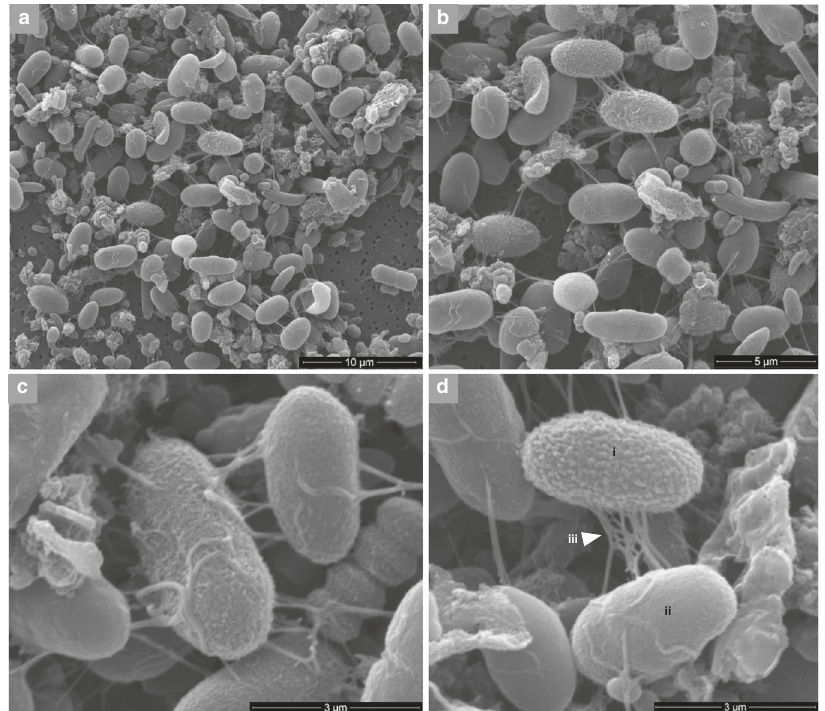
Fig. 4 | Scanning electron microscopic images of putative Quinella cells and other cells in sample 3. Panels b – d are magni fi ed views of panel a . Features: (i) granular cell type; (ii) smooth cell type; (iii) unidenti fi ed material peeling off from cell surface, possibly a dehydrated glycocalyx or denatured surface associated